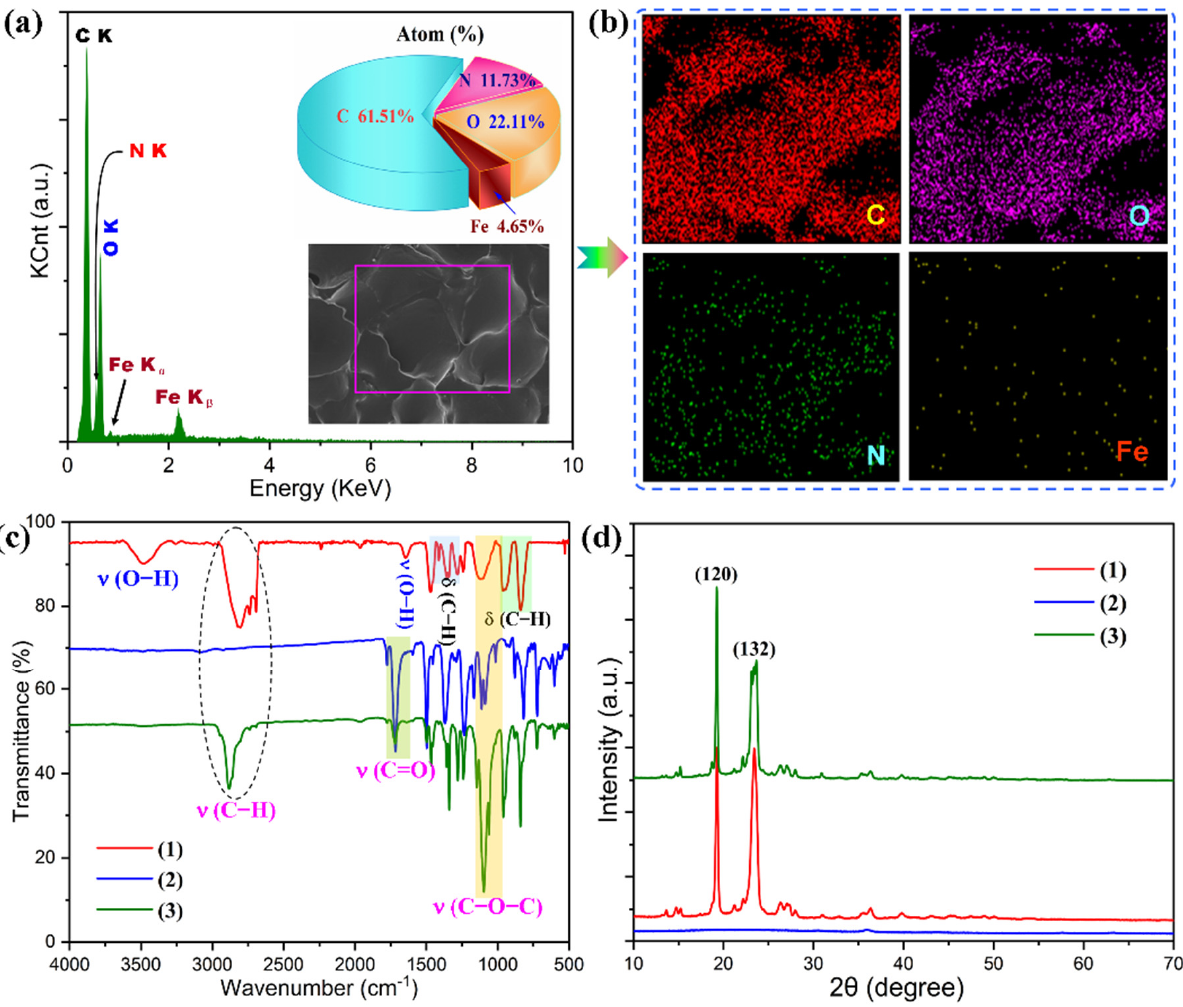
Figure 9. ( a ) EDX spectrum and ( b ) elemental mapping images of the PI/graphene/Fe 3 O 4 aerogel/PEG composite film. ( c ) FTIR spectra and ( d ) XRD patterns of (1) pure PEG, (2) the PI/graphene/Fe 3 O 4 aerogel film, and (3) PI/graphene/Fe 3 O 4 aerogel/PEG composite film.